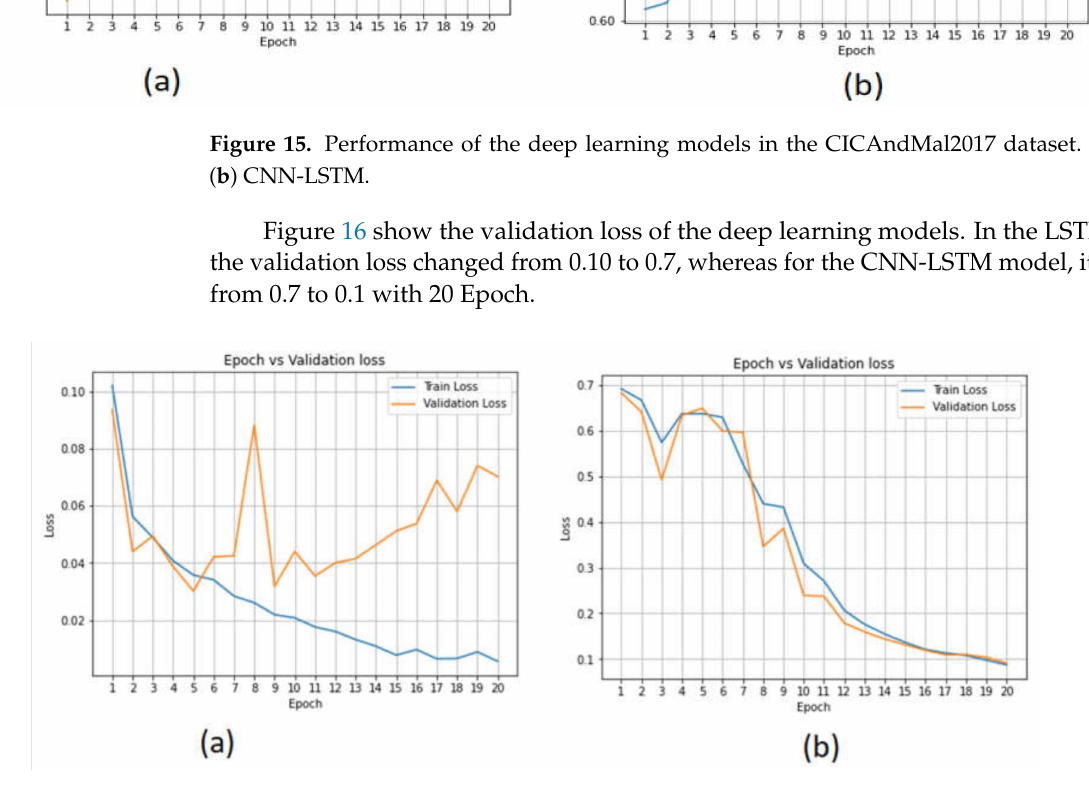
Figure 16. Accuracy loss of the deep learning models in the CICAndMal2017 dataset. ( a ) LSTM. ( b )